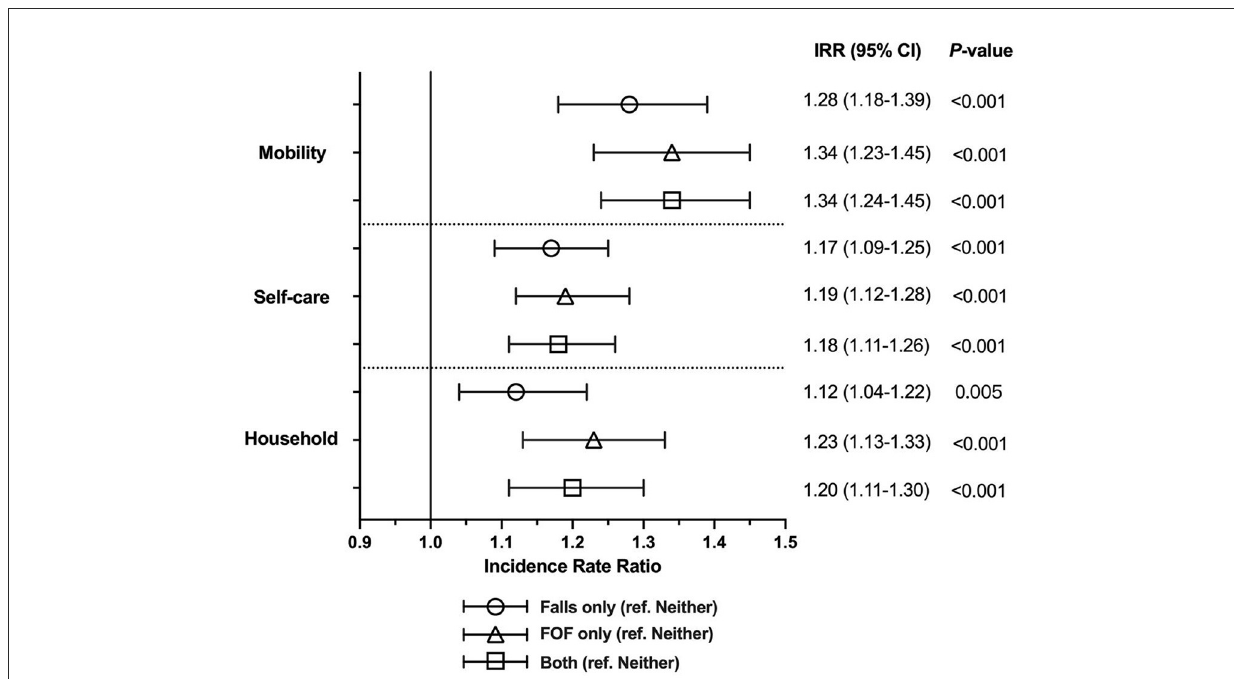
FIGURE1 Forest plot depicting fully adjusted Poisson regression analysis of baseline falls and FOF status on functional limitations at R2. Models adjusted for sociodemographic factors (age, sex, race/ethnicity, education) and health-related factors (obesity, depressive symptoms, anxiety symptoms, bothersome pain, visual impairment, dementia, hospitalization, number of chronic diseases, and Short Physical Performance Battery) and outcome of interest at baseline. FOF, fear of falling; IRR, incidence rate ratio; CI, confidence